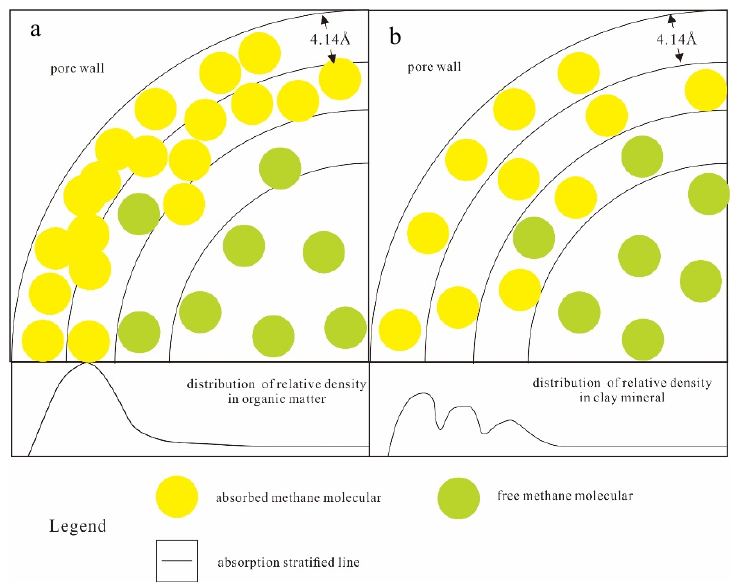
Figure 4. The distribution of methane molecules in shale nanoparticles. ( a ). in organic matter; ( b ). in clay mineral).